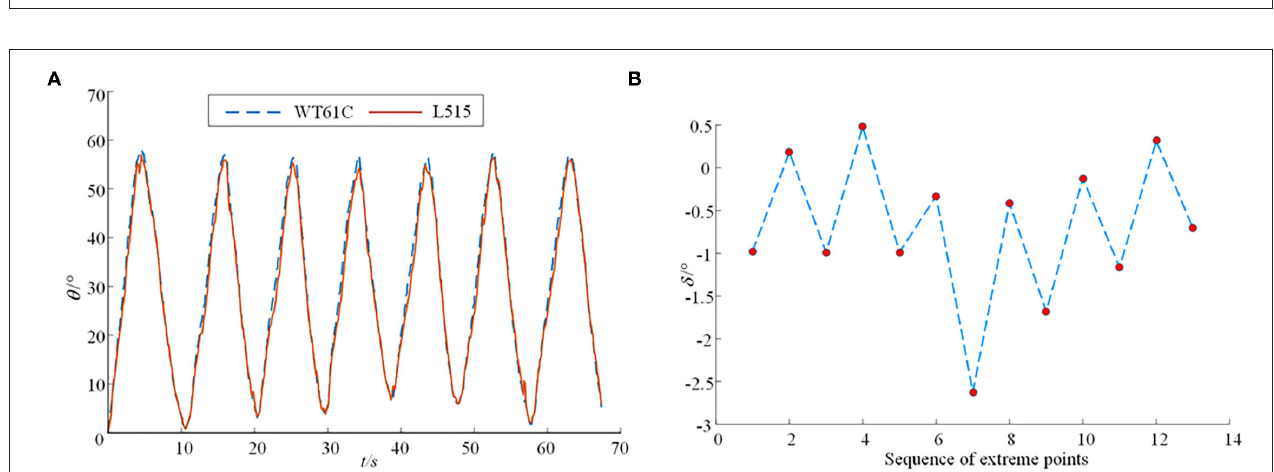
FIGURE 11 | The results from the joint range of motion detection system for the joints in the sagittal plane. (A) The detection of motion angle in the sagittal plane; (B) Error diagram between the control group and experiment group for comparison in the sagittal plane.